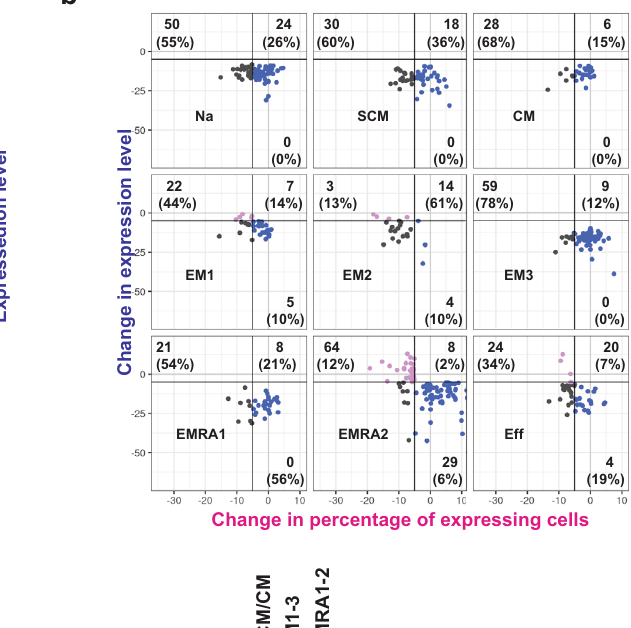
decreasing across age into three modes of change in nine clusters identi fi ed by scRNA-seq (Full gene list is in Supplementary Data 4). c . Bubble plot showing functional gene sets enriched for each of three modes of change across age. Representative genes for each gene set shared across clusters shown. NES, nor- malized enrichment score. The scale of the magnitude of signi fi cance is 0 to 10 − 5 . GO, gene